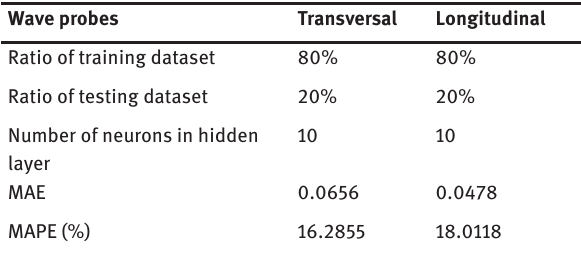
Figure 3 : Regression Analysis Results of two Developed ANN Models.